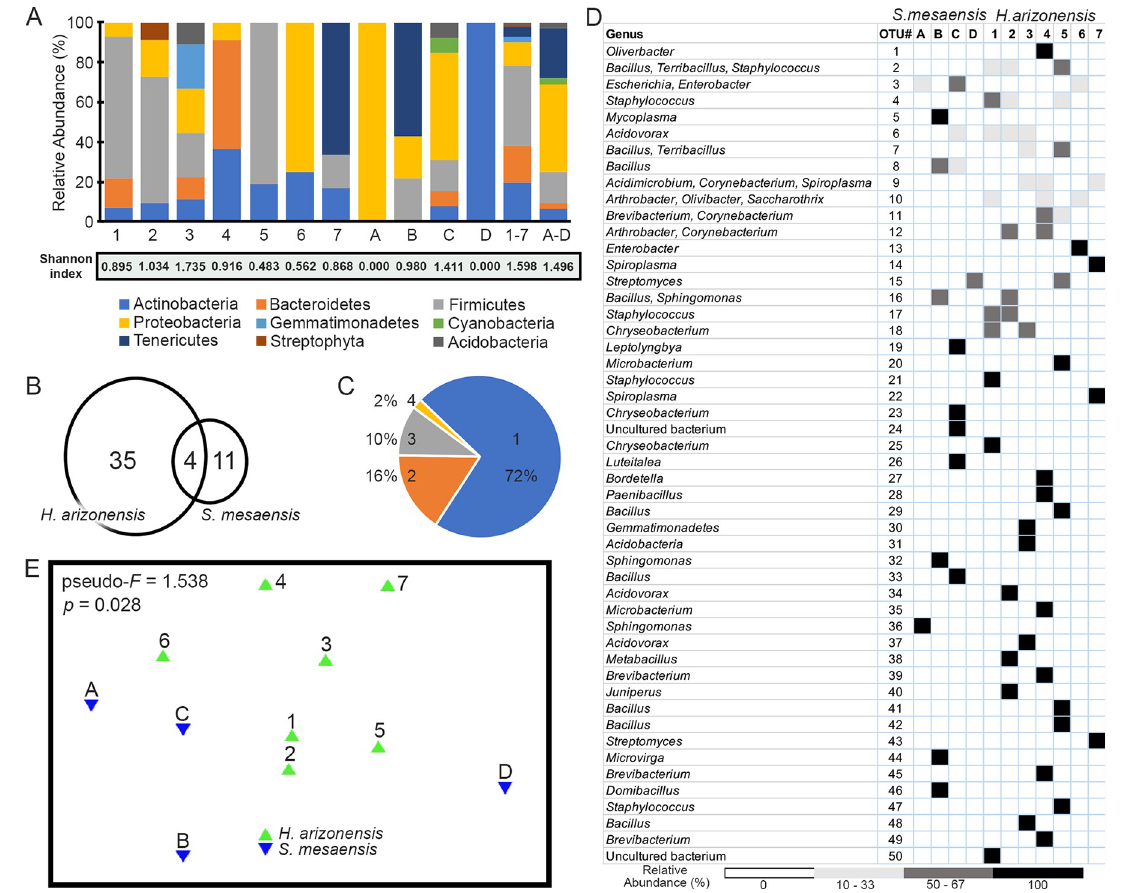
Fig 2. Composition of the S . mesaensis and H . arizonensis telson microbiota. A) Taxonomic assignments at the phylum level for individual samples and the aggregated data (right side) for each species. The Shannon index value for each sample is shown below the graph. B) The OTU distribution by species shows that most OTUs (46 out of 50) were unique to the host species; only 4 OTUs were common to both. C) The percentage distribution of OTUs shows the vast majority of OTUs were found in only one scorpion, and a single OTU was never found in more than four scorpions. D) Heatmap of the relative abundance (%) of each OTU and their assigned genera from BLAST results. The columns represent individual scorpions. The relative abundance is calculated as the percentage of OTU sequences per scorpion. White = 0%; light gray = 10–33%; dark gray = 50–67%; black = 100%. E) Bray-Curtis similarity and PERMANOVA indicate the centroids differ statistically between the microbiota in each scorpion species (pseudo- F = 1.538, p = 0.028, df = 10). Triangles represent individual scorpions; green– H . arizonensis , blue– S . mesaensis . For (A), (D), (E), 1 to 7 are H . arizonensis , A to D are S . mesaensis